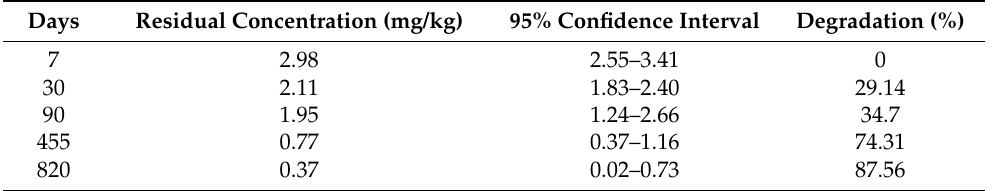
Table 2. The degradation proportion of fluopyram in the branches and needles of pine trees after their treatment with the suspension